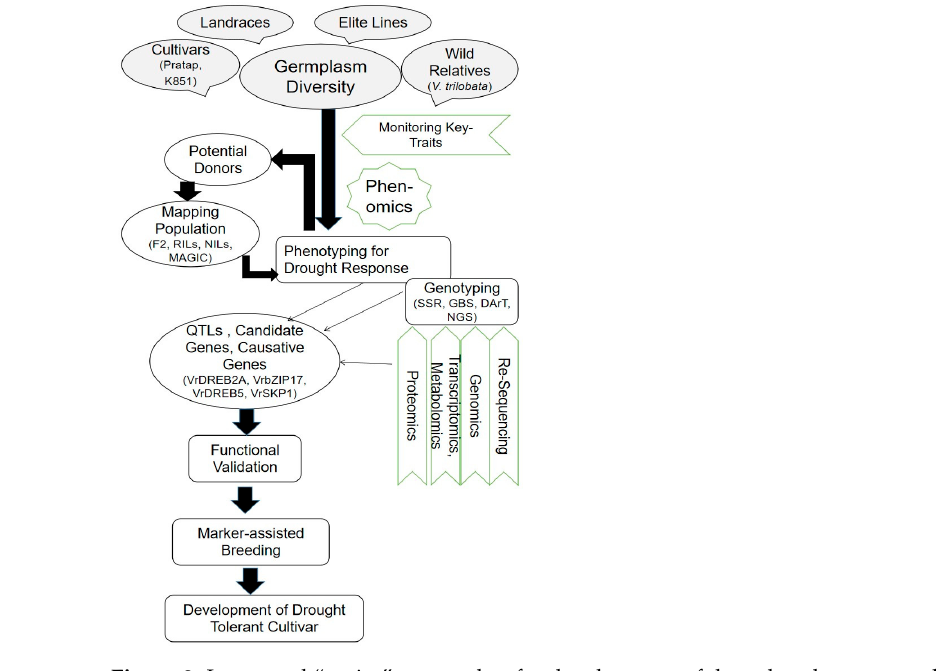
Figure 2. Integrated “omics” approaches for development of drought tolerant mungbean genotypes.